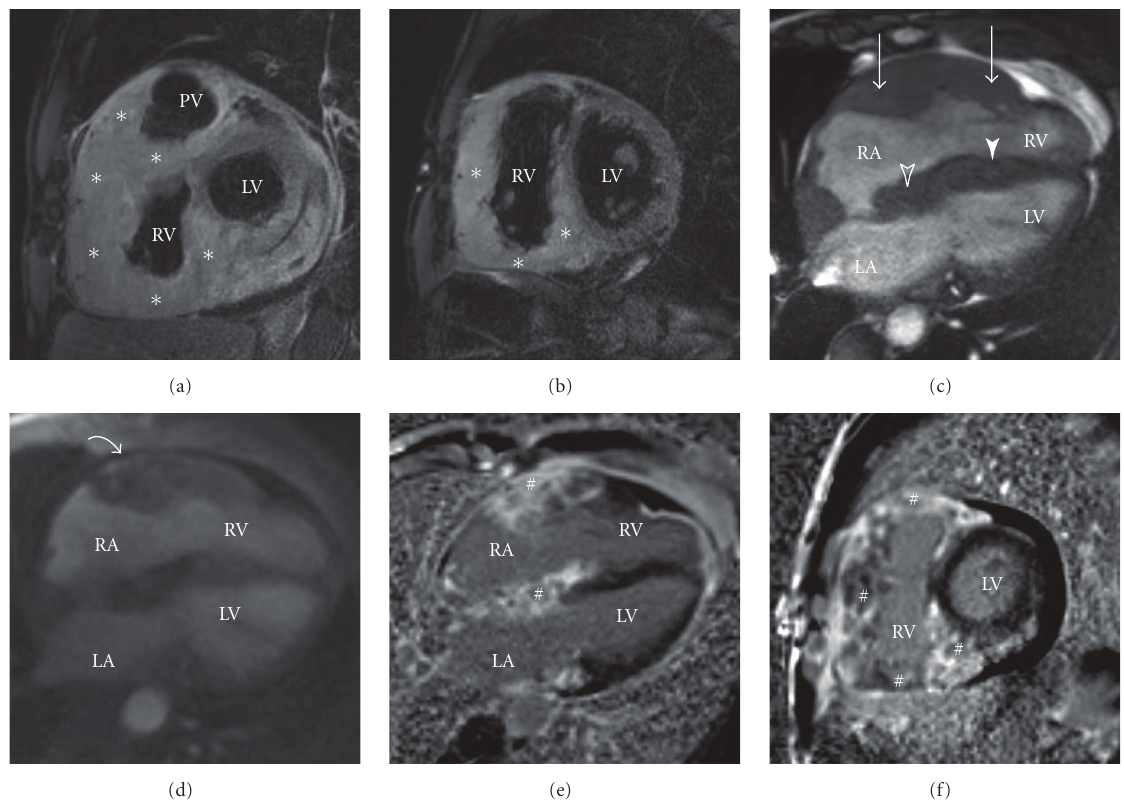
Figure 3: T2-weighted short inversion-time, inversion-recovery (STIR) breath hold pulse sequences ((a) and (b)) showing concentric thickening and oedema of the right ventricle. The infiltration (asterisk) extends around the root of the pulmonary artery. Four-chamber SSFP cine view (c) showing infiltration of the right ventricle (arrow), right atrium (empty arrow), interatrial septum (empty arrowhead), and basal to mid interventricular septum (arrowhead). Four-chamber first-pass T1-weighted multishot gradient-echo echo-planar sequence (d) shows partial hyperenhancement (arrow) of the right ventricle in support of an inflammatory process. Four-chamber (e) and short-axis (f) three-dimensional phase-sensitive inversion recovery sequences demonstrating widespread and heterogeneous enhancement (#) of the right atrium and ventricle. RA indicates right atrium; LA, left atrium; RV, right ventricle; LV, left ventricle; PV, pulmonary valve.